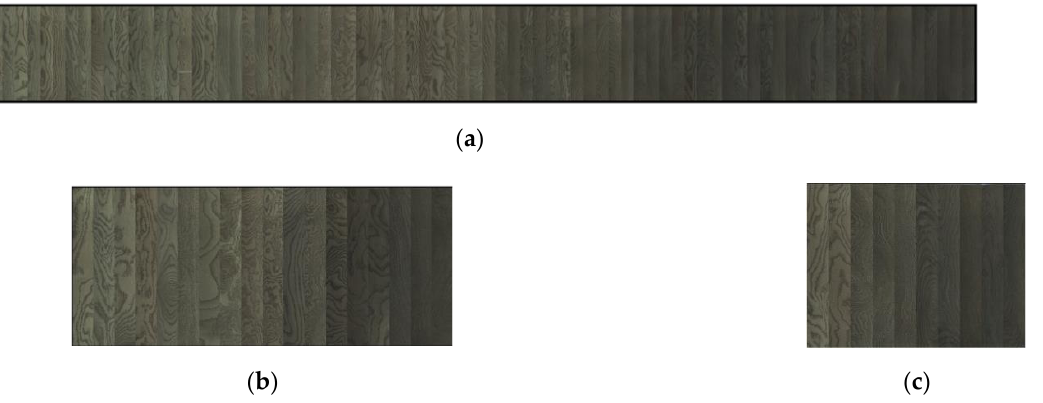
Figure 7. Solid wood floor datasets. ( a ) Training set solid wood board images. ( b ) Validation set of solid wood board images. ( c ) Test set of solid wood board